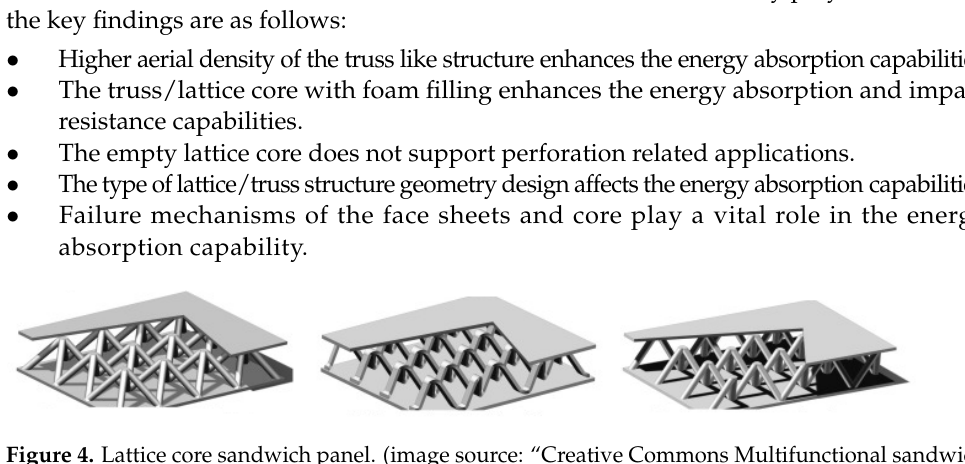
Figure 4. Lattice core sandwich panel. (image source: “Creative Commons Multifunctional sandwich panel with metallic lattice cores” by Zhang et al. https://doi.org/10.3390/en10070906 (accessed on 18 August 2021), used under CC BY 4.0, modified from original). Table 4. Sandwich structure with truss/lattice like structure as core.